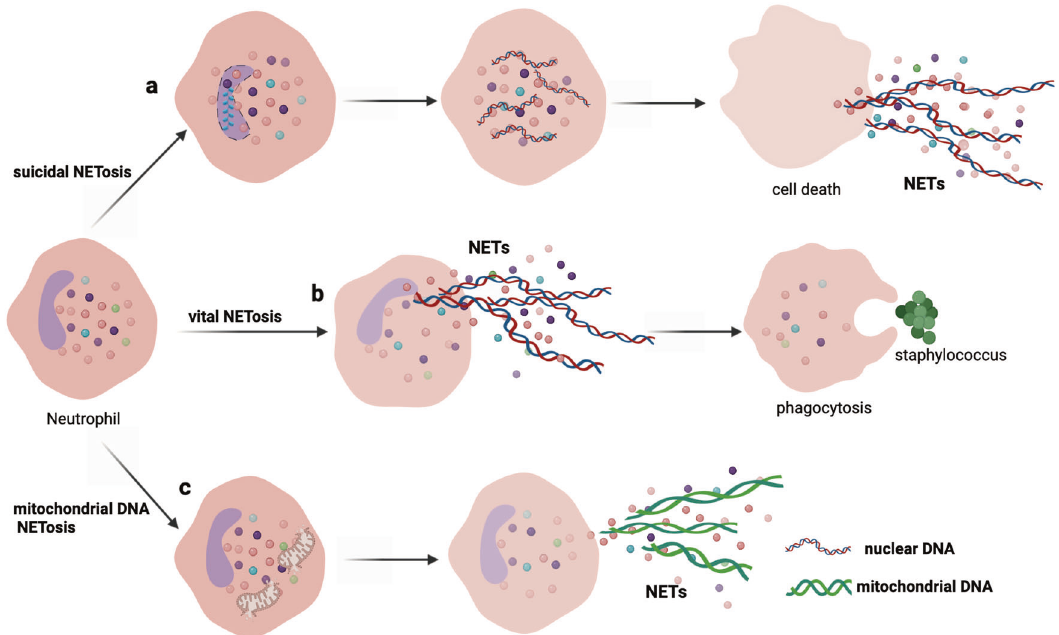
Fig. 1 Three types of NET formation. a The fi rst type is classic suicidal NET formation, which is characterized by nuclear chromatin decondensation, NET release, membrane rupture, and cell death. b The second type is vital NET formation; after releasing NETs, neutrophils are intact and remain phagocytic. c The third type is mitochondrial DNA NET formation, which triggers NET formation from mitochondrial DNA but not nuclear